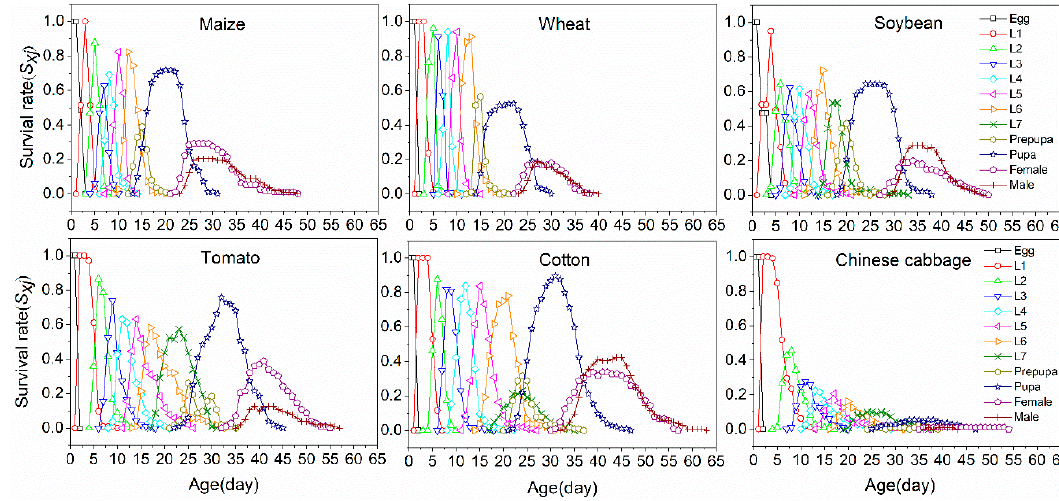
Figure 2. Age-stage specific survival rate ( s x j ) of S. frugiperda fed on six plant